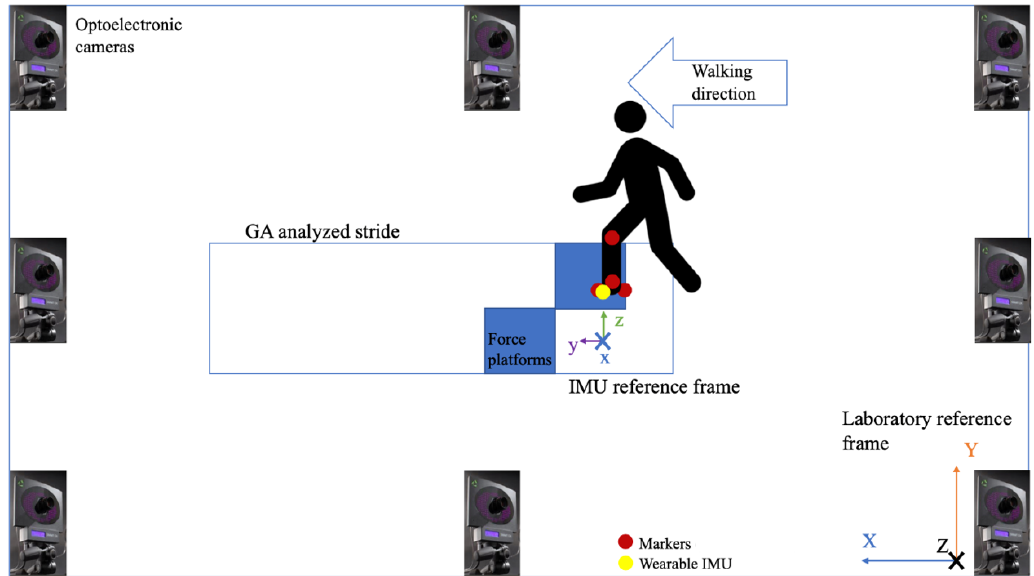
Figure 2. Experimental setup—tests were conducted on the middle laboratory lane with force platform embedded on the floor. Motion capture cameras are fixed on the wall in a standard gait analysis configuration.